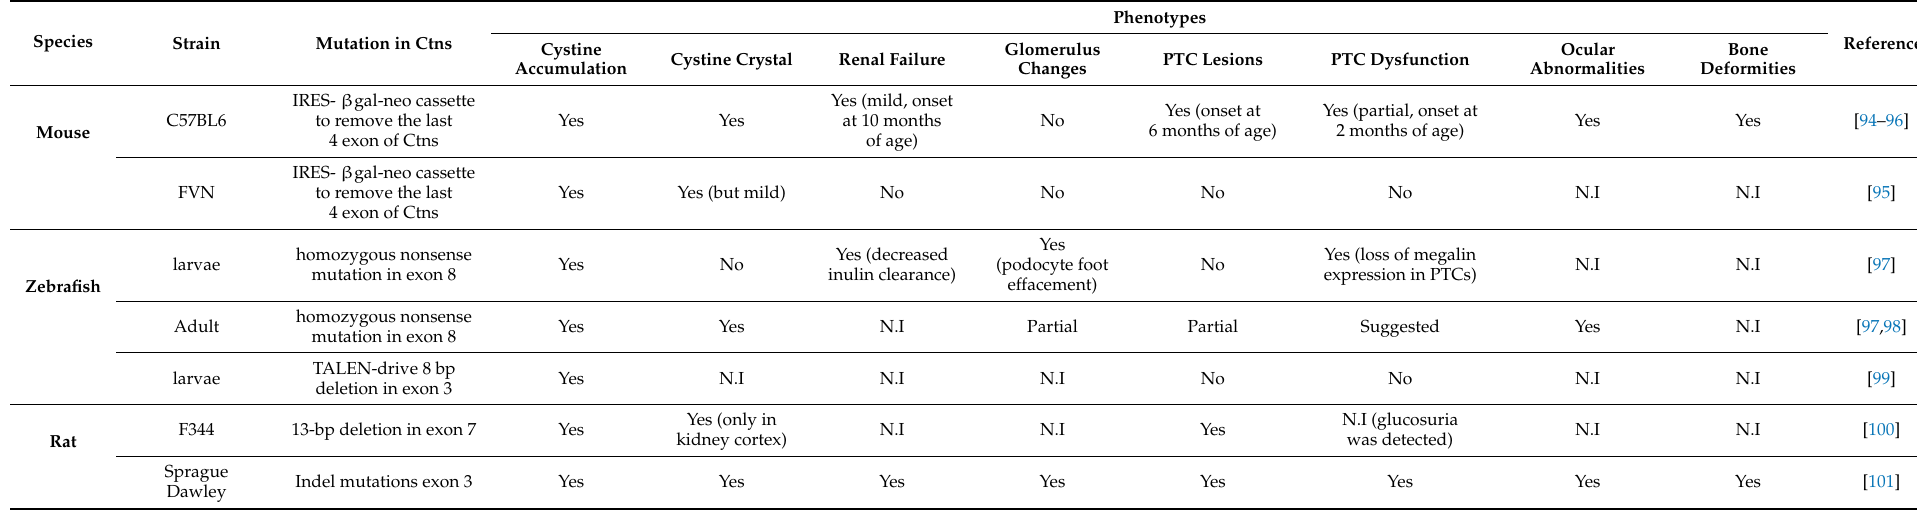
Table 1. Comparison of cystinotic in vivo models PTC = proximal tubule cells, dpf = days post fertilisation, N.I = not